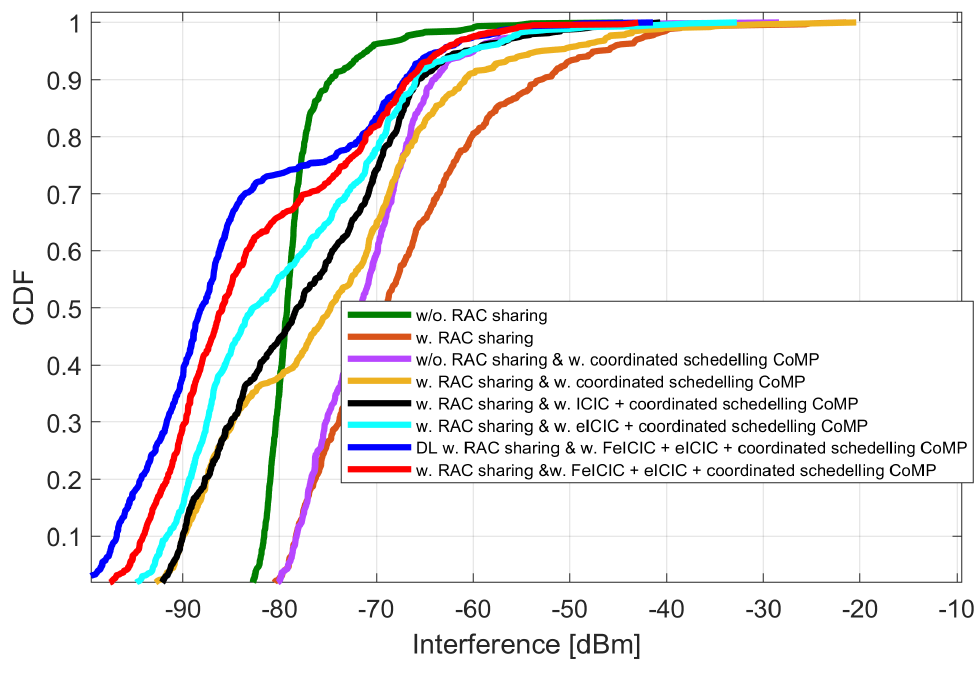
Figure 5. Interference vs.